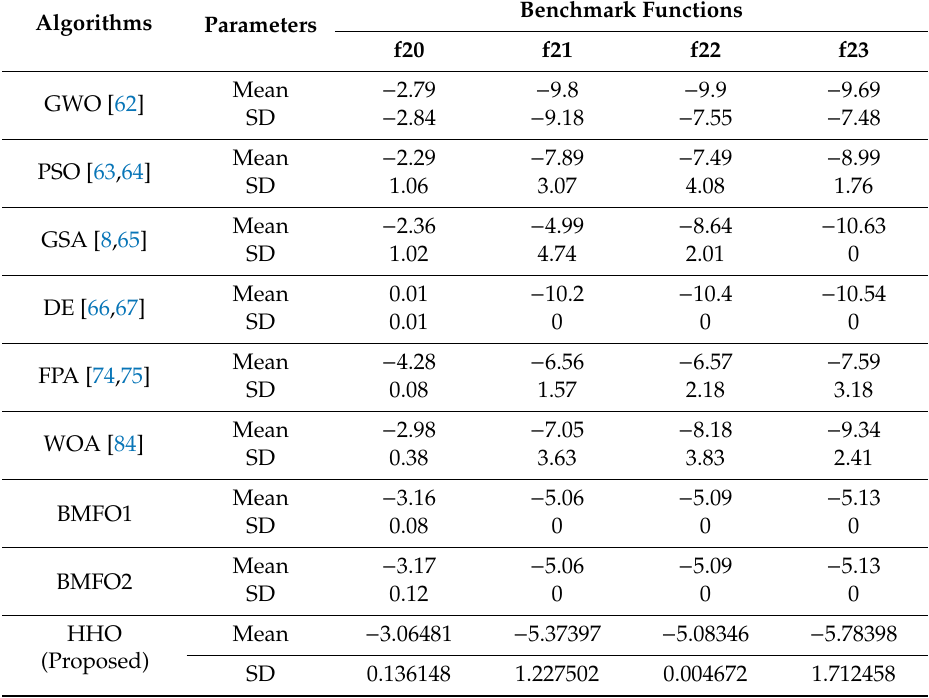
Table 10. Comparison of results for fixed dimension